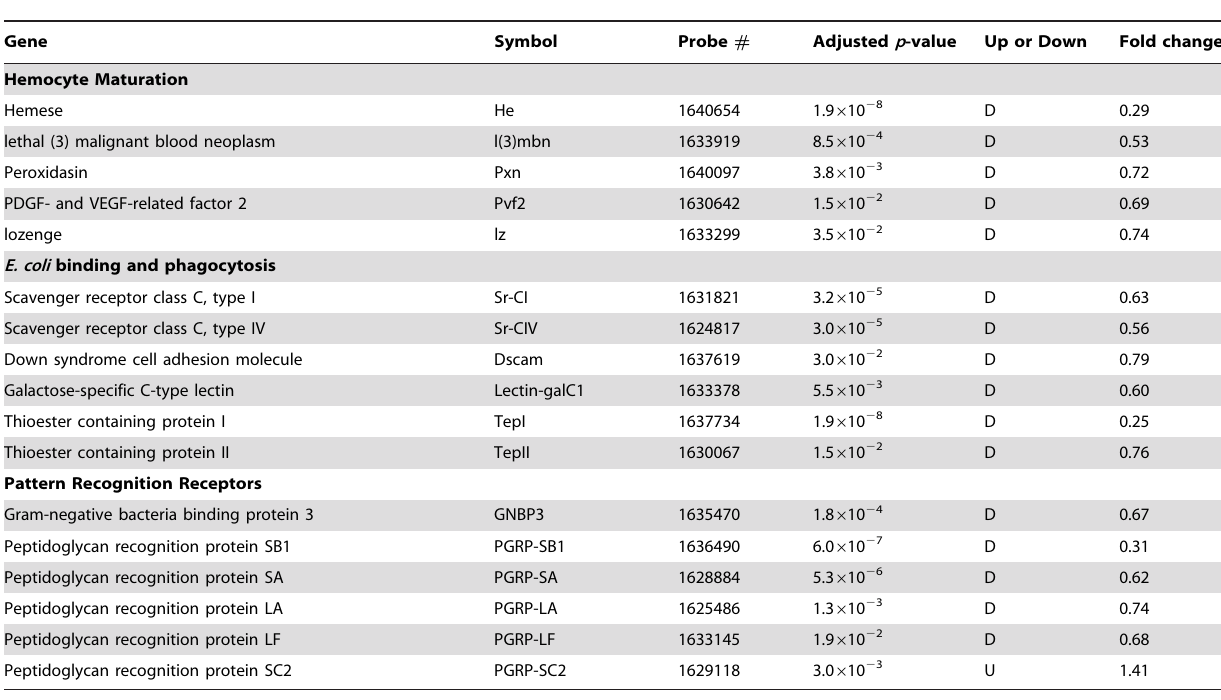
Table 1. The expression of genes involved in hemocyte maturation and pathogen recognition and binding is downregulated in spaceflight